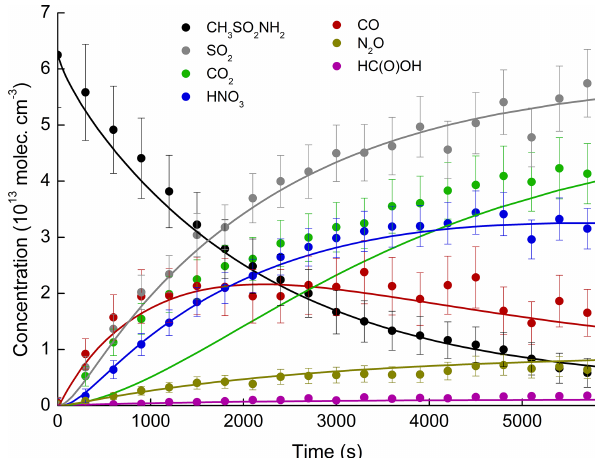
Figure 8. Concentration–time profiles of MSAM and reaction prod- ucts formed in an experiment at 298K and 700Torr air. The er- ror bars represent uncertainty in infrared cross sections. The uncer- tainty associated with the MSAM concentration is estimated to be ≈ 25%. Solid lines are simulated